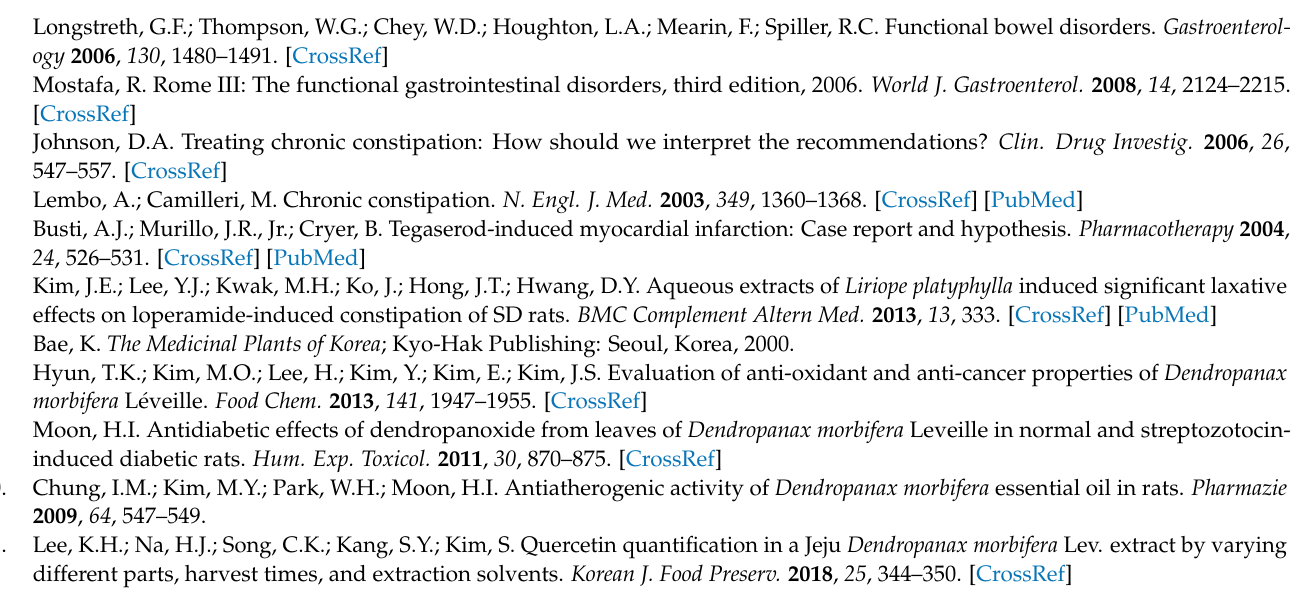
Table S2: Measurement of body weight, feed intake, and water intake in Sprague–Dawley (SD) rats with low-fiber diet-induced constipation, Table S3: Measurement of fecal parameters in rats with loperamide-induced